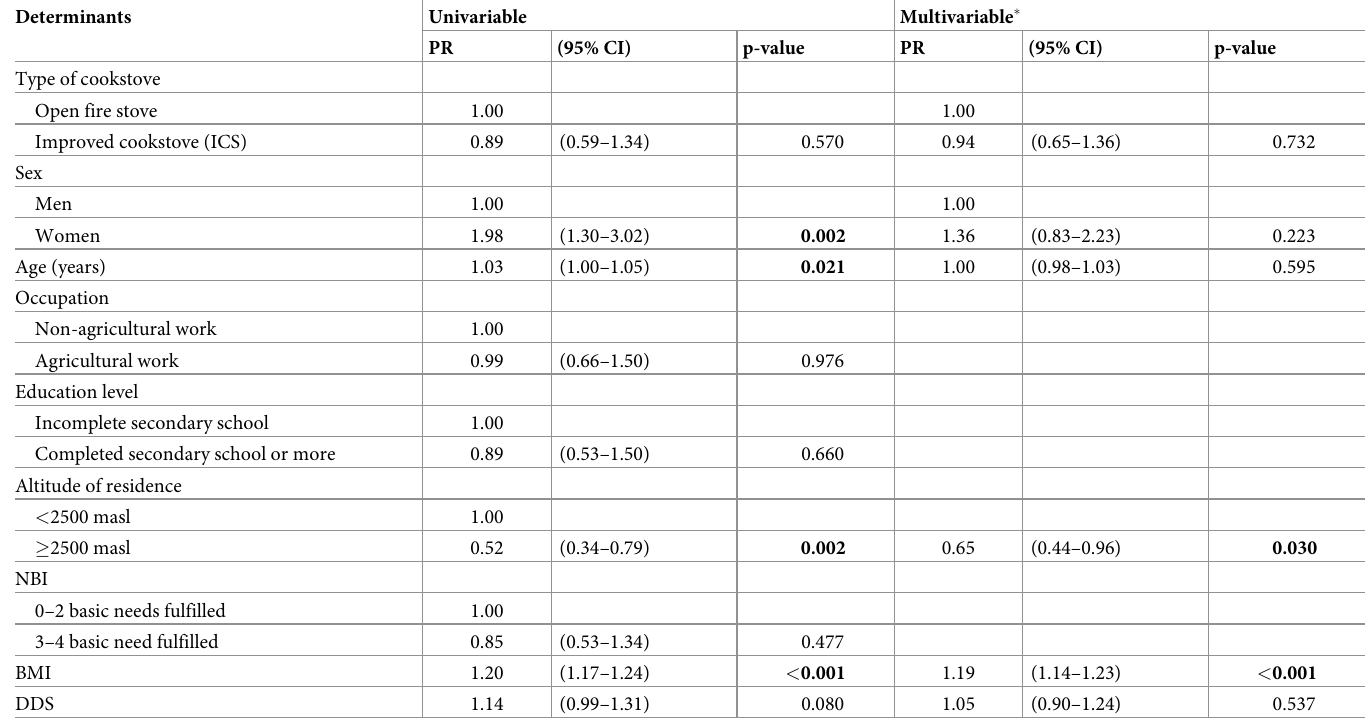
Table 3. Univariable and multivariable analysis of determinants of metabolic syndrome in adults of the provinces of San Marcos and Cajabamba,